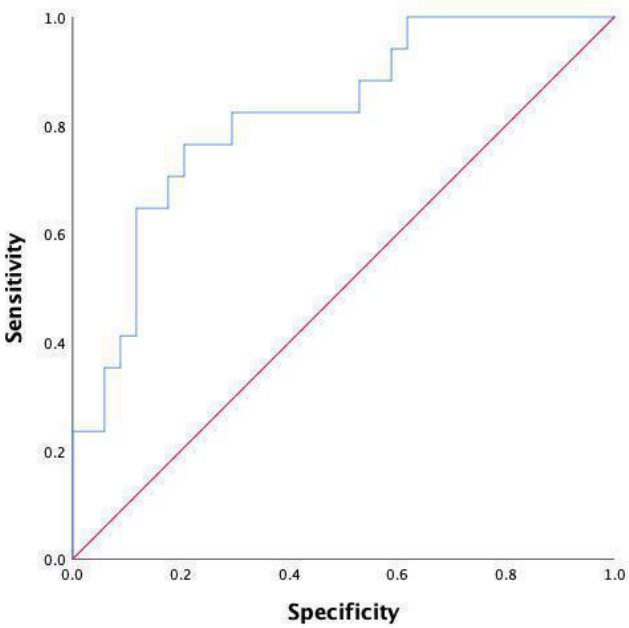
Figure 5. ROC curve of N and NLR after PSM analysis on day 5 after surgery.